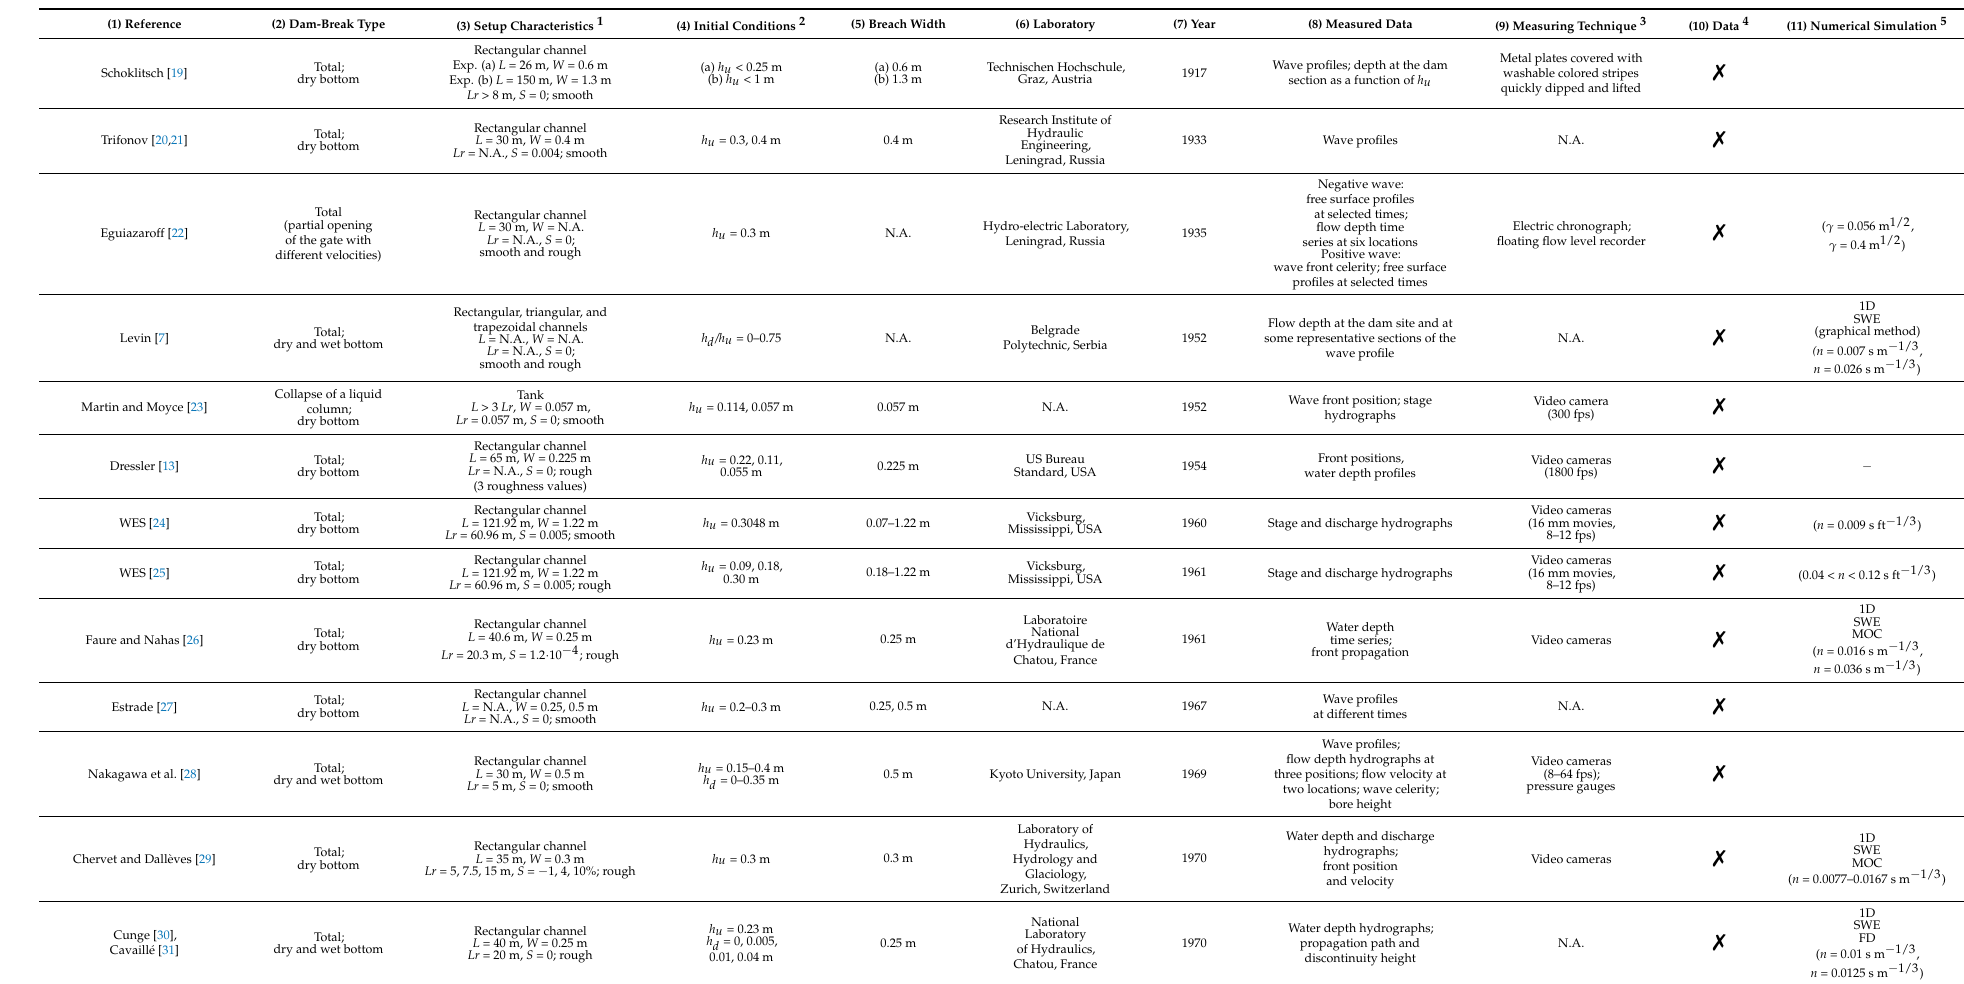
Table 1. Basic experimental investigations of fundamental dam-break wave physical characteristics.